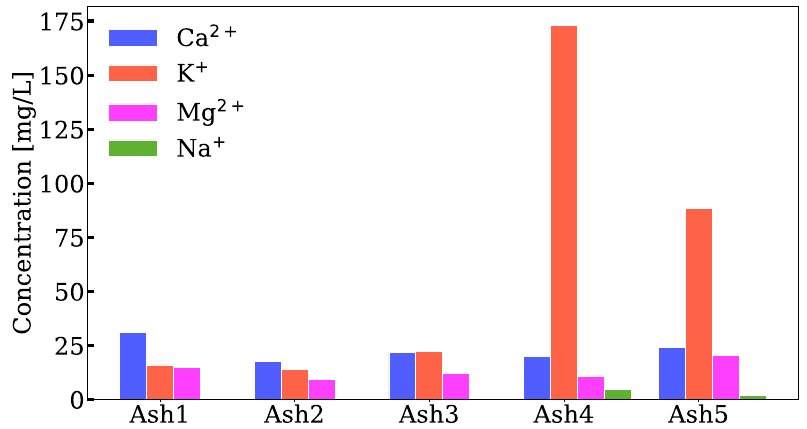
Figure 2. Major cation concentrations leached from ash via rainwater by sampling